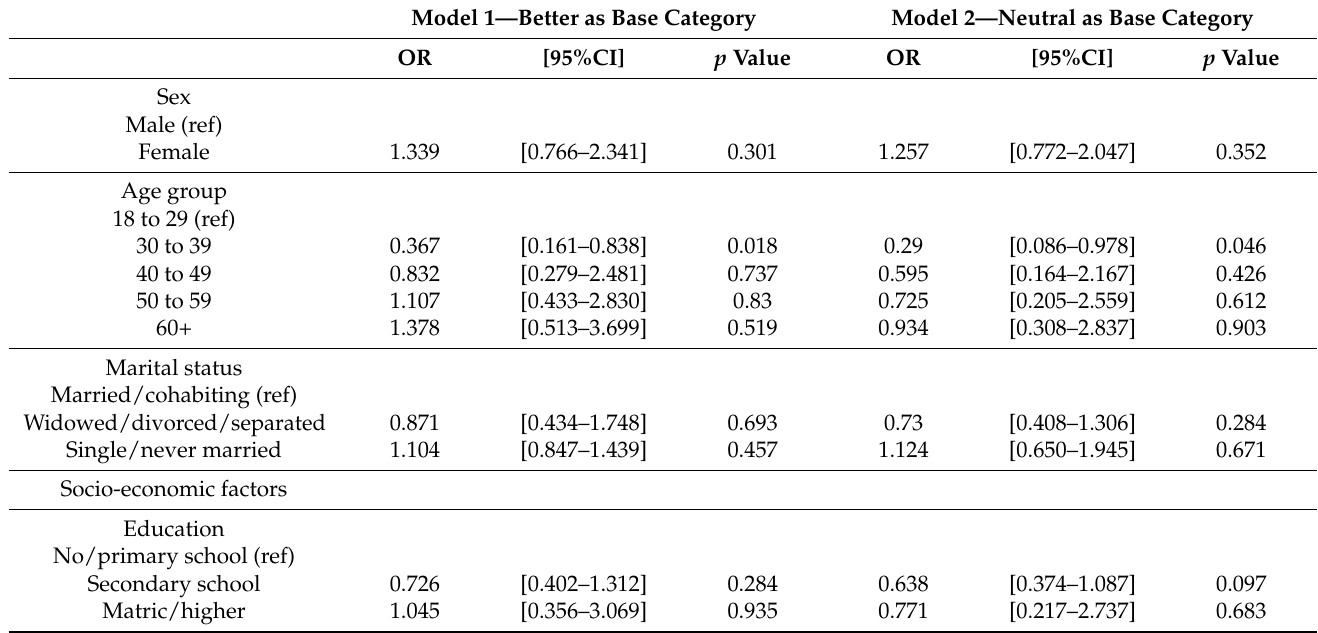
Table 4. Multinomial logistic regression models showing factors associated with deteriorated SPH status among informal settlement